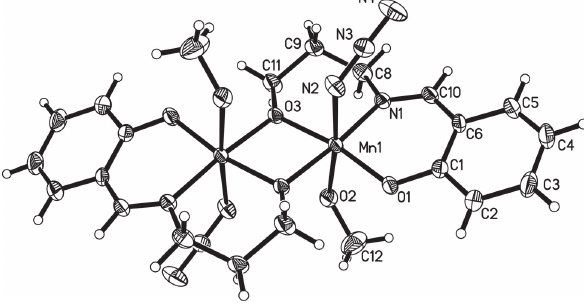
Table 1: Data collection and